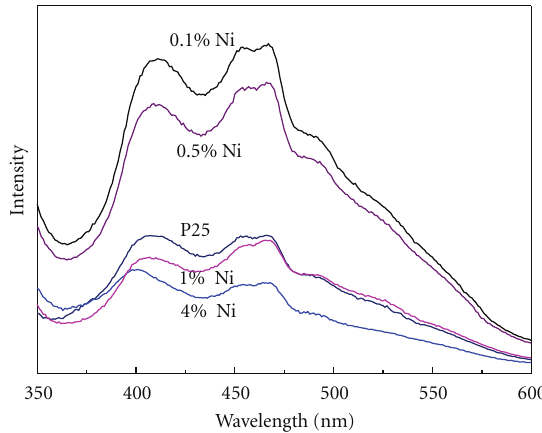
Figure 7: Photoluminescence spectra of prepared TiO 2